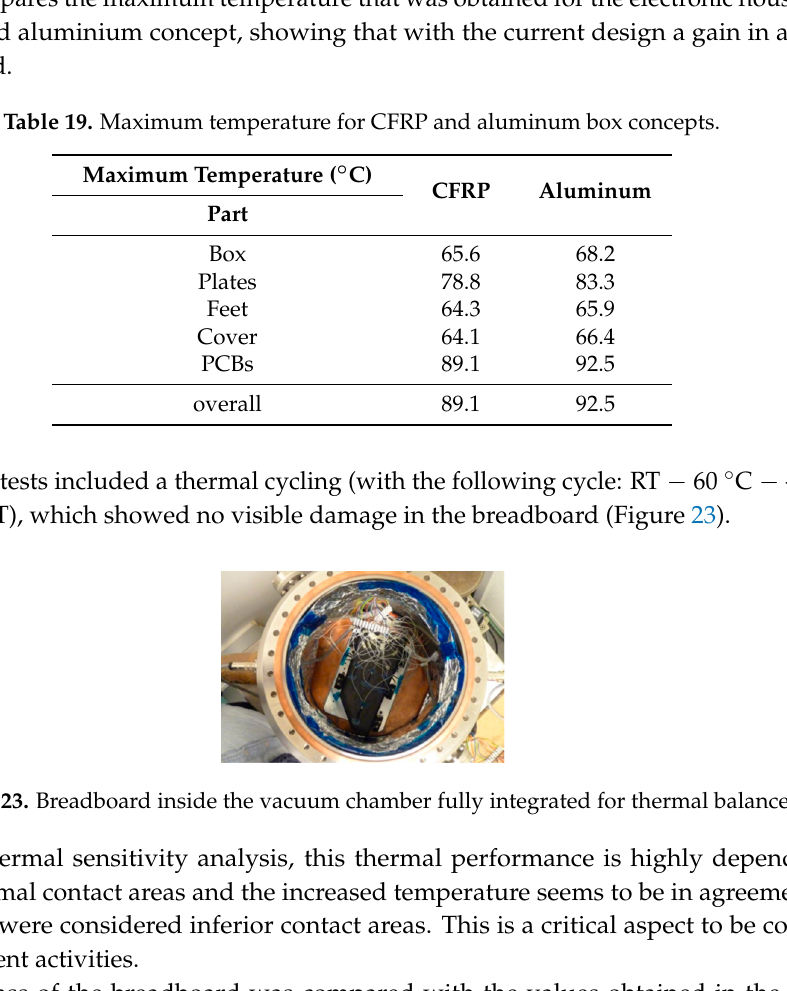
Table 20. Mass budget of breadboard.